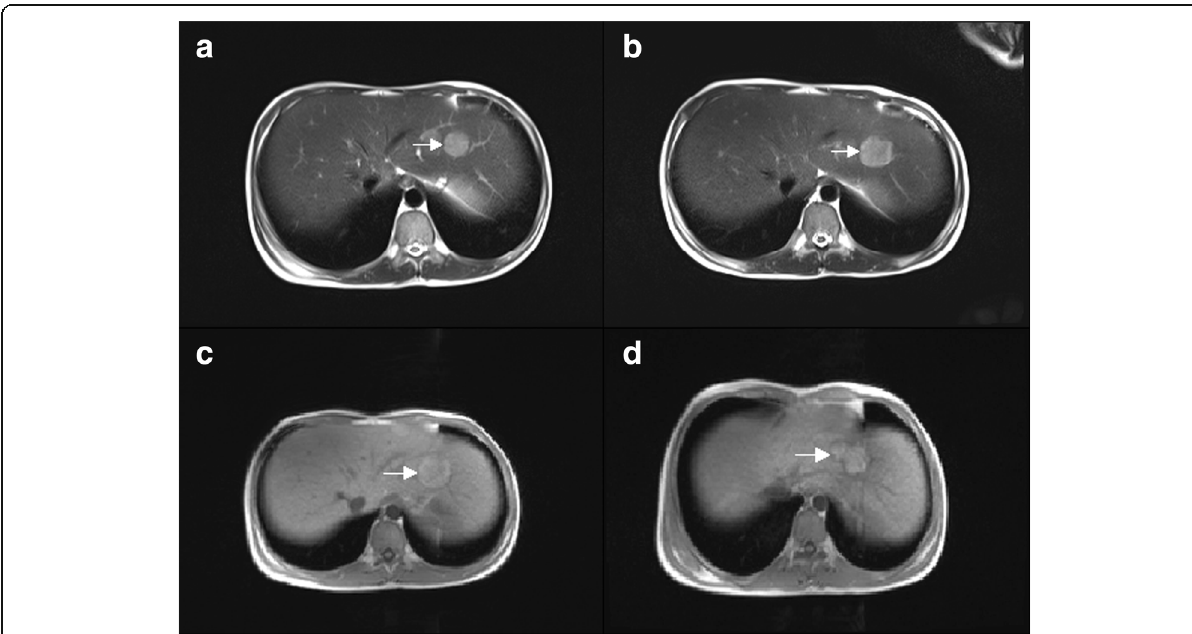
Fig. 1 The Gd-EOB-DTPA tumor specific detection showed: glycogen accumulation. Arrow shows the largest nodule. a MRI (Gd-EOB-DTPA) examined on base line (2016.11.11 at presentation), the max size of nodules was 23 mm. b MRI (Gd-EOB-DTPA) examined 9 months after diagnosis of GSD I, the max size of nodules was 27 mm ( c ). MRI (Gd-EOB-DTPA) examined 12 months after diagnosis of GSD I, the max size of nodules was 34 mm. d MRI (Gd-EOB-DTPA) examined after radiofrequency ablation